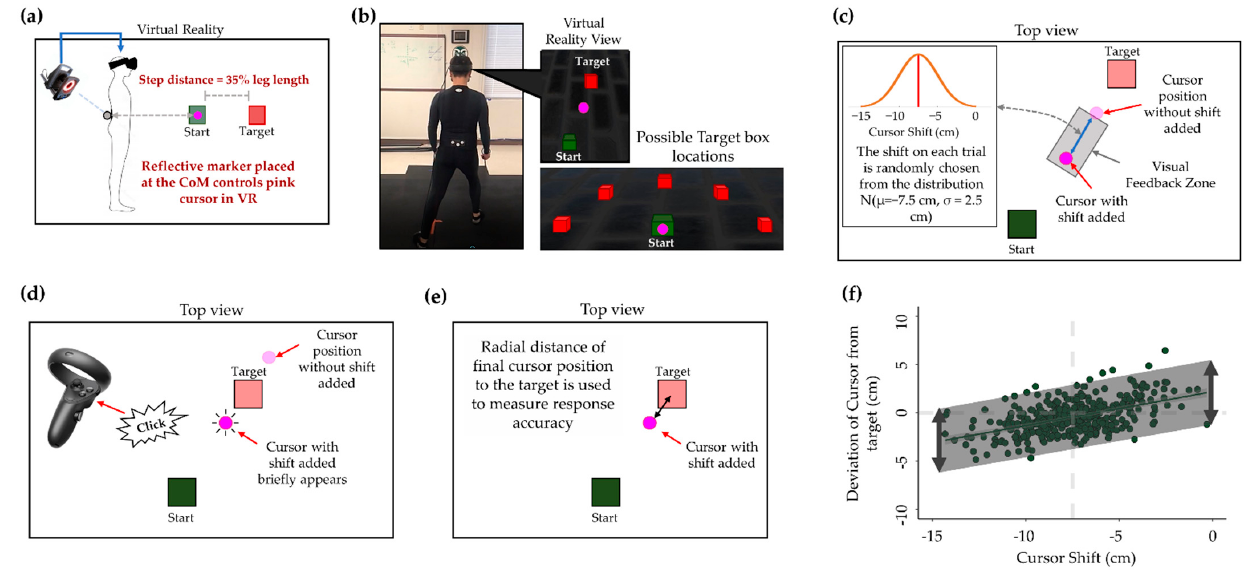
Figure 2. The Bayesian inference motor learning protocol and analysis. Participants completed a training block of 100 trials to learn to expect the radial shift added to the cursor position, and then five more blocks of 100 trials that were included in the final analysis. CoM = center of mass. ( a ) Participants bring a cursor (controlled by their CoM) from a start box to a target box with a single step. ( b ) On each trial, the target will appear in one of five positions, prompting a step in different directions, depending on the target displayed. ( c ) Participants only get to see the cursor within the visual feedback zone where a backwards radial shift is added to its position, prompting them to step further than necessary to bring the cursor into the target position. ( d ) Participants click a button on the VR controller when they believe the unseen cursor is in the target box, after which its position is briefly shown to promote continuous learning of the backwards shift. ( e ) The amount of cursor shift and radial distance of the final cursor position from the target on each trial are used for analysis. ( f ) The root mean squared error (RMSE) of the regression line between the amount of cursor shift was used to quantify the amount of uncertainty in participants’ responses for each study visit.